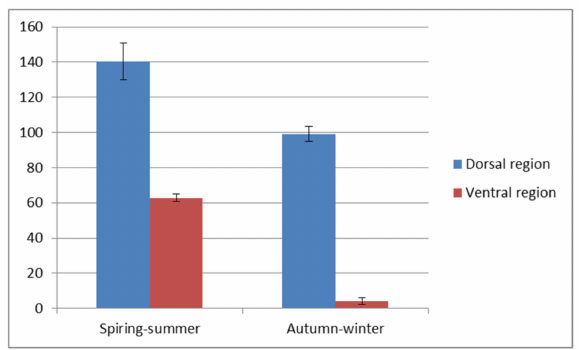
Figure 3. Epithelium thickness ( µ m) in the dorsal and ventral skin of the investigated fish.